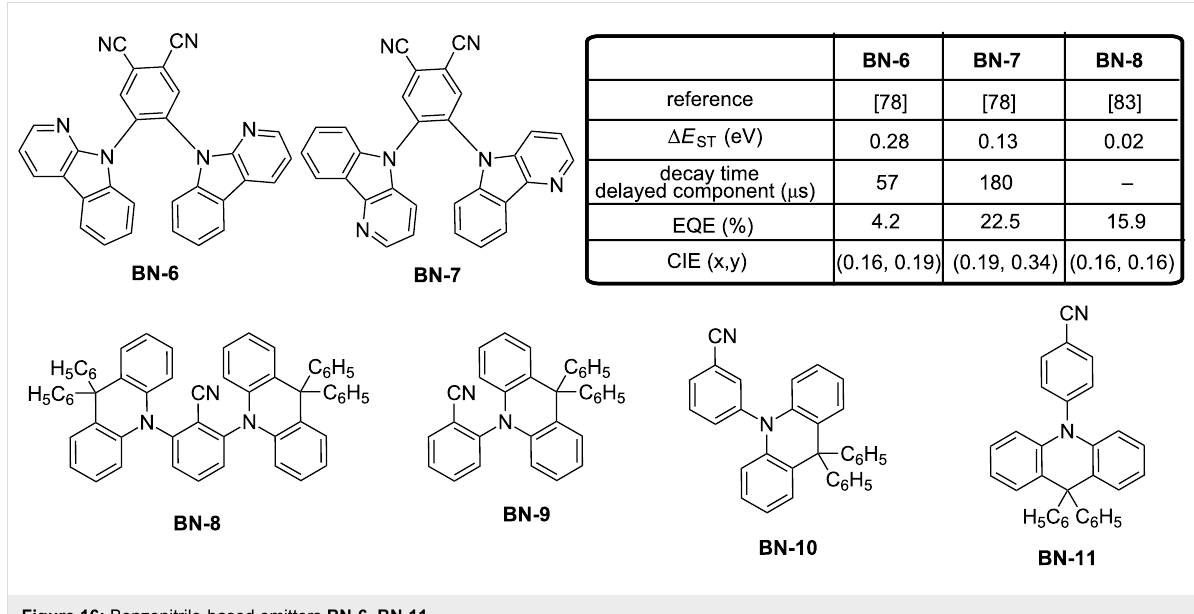
radiative processes, adversely affecting the EL